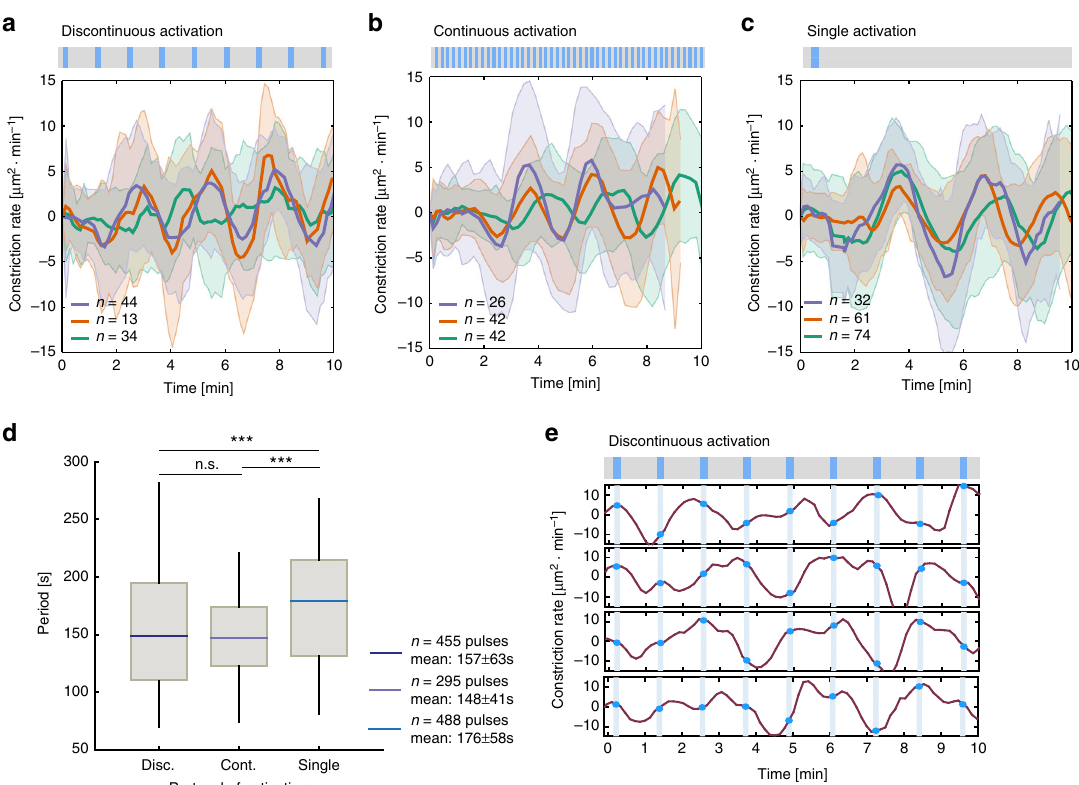
Fig. 3 Induction of pulsatile apical contractions. a – c Constriction rate of photo-activated cells measured by change in apical area over time. Positive values indicate contractions while negative values indicate expansions. Embryos co-expressing CIBN::pmGFP, RhoGEF2-CRY2::mCherry, and the plasma membrane marker Gap43::mCherry ( N = 9) were subjected to different illumination protocols. In all cases, cell outlines were recorded in mCherry (Gap43:: mCherry) during and after photo-activation. Data presented as mean (solid line) and s.d. (shaded area). A rectangular region on the dorsal epithelium was photo-activated using two-photon illumination in a single plane, centered at 4 µ m from the apical-most plane. a Discontinuous photo-activation (10 mW) with a resting interval of 55 s ( N = 3 embryos, n = 44, 13, 34 cells). b Continuous photo-activation (5 mW, N = 3 embryos, n = 26, 42, 42 cells). c Single initial photo-activation (15 mW, N = 3 embryos, n = 32, 61, 74, cells). d Box-and-whisker plot of the quanti fi ed period between peaks of constriction for the indicated protocols. The quanti fi ed constriction pulses correspond to the data in a – c , ( n = 455, 295, 488 pulses, *** p < 0.001, two-tailed paired t -test). e Constriction rate over time for four individual cells during the discontinuous activation protocol (blue markers indicate time of